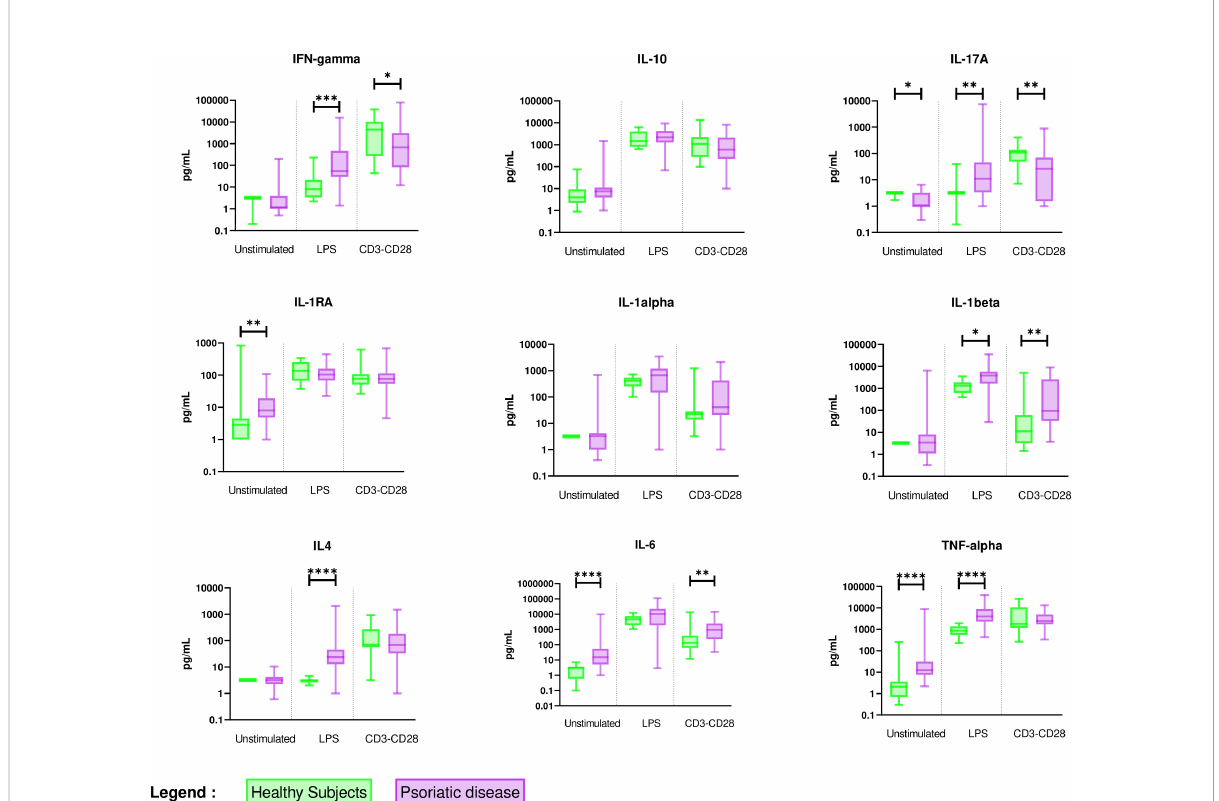
FIGURE 1 Overall comparison of ex vivo cytokine production in PBMC supernatants between healthy subjects (n = 11) and PsD patients (n = 48). PBMCs from healthy subjects (n = 11) and PsD patients (n= 48) were cultured at 1x10 6 cells/ml for 24 h at 37°C, 5% CO 2 with and without stimulation of monocytes by E. coli LPS (1 µg/mL) or T lymphocytes by anti-CD3/CD28 mAb (2.5 × 10 4 beads/10 6 cells/ml). Supernatants were collected and cytokine levels were assayed by Luminex Multiplex ELISA. Results are presented using median values with minimum to maximum box-plot. Difference between the groups using non-parametric Mann-Whitney U test is presented in the top of the fi gure for each condition. * p < 0.05; ** p < 0.01; *** p < 0.001; **** p <